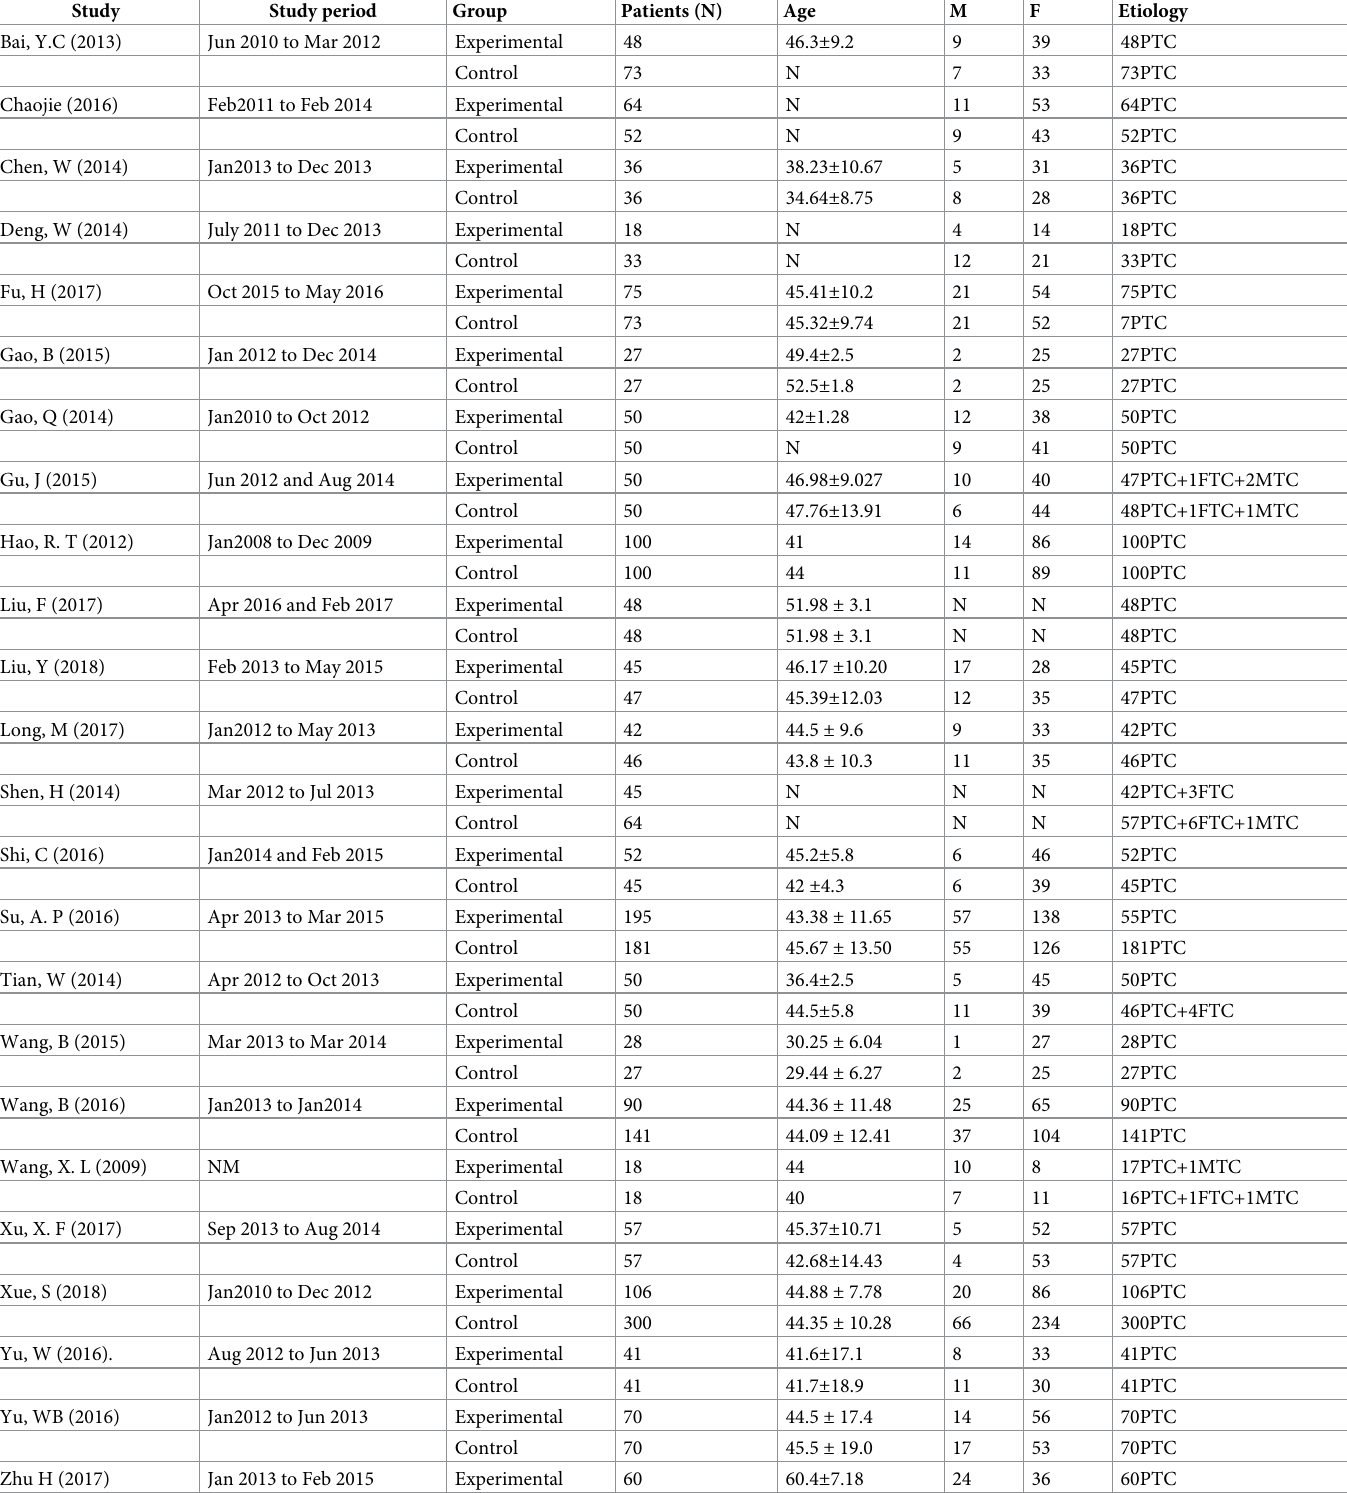
Table 1. Characteristics of the articles included in the